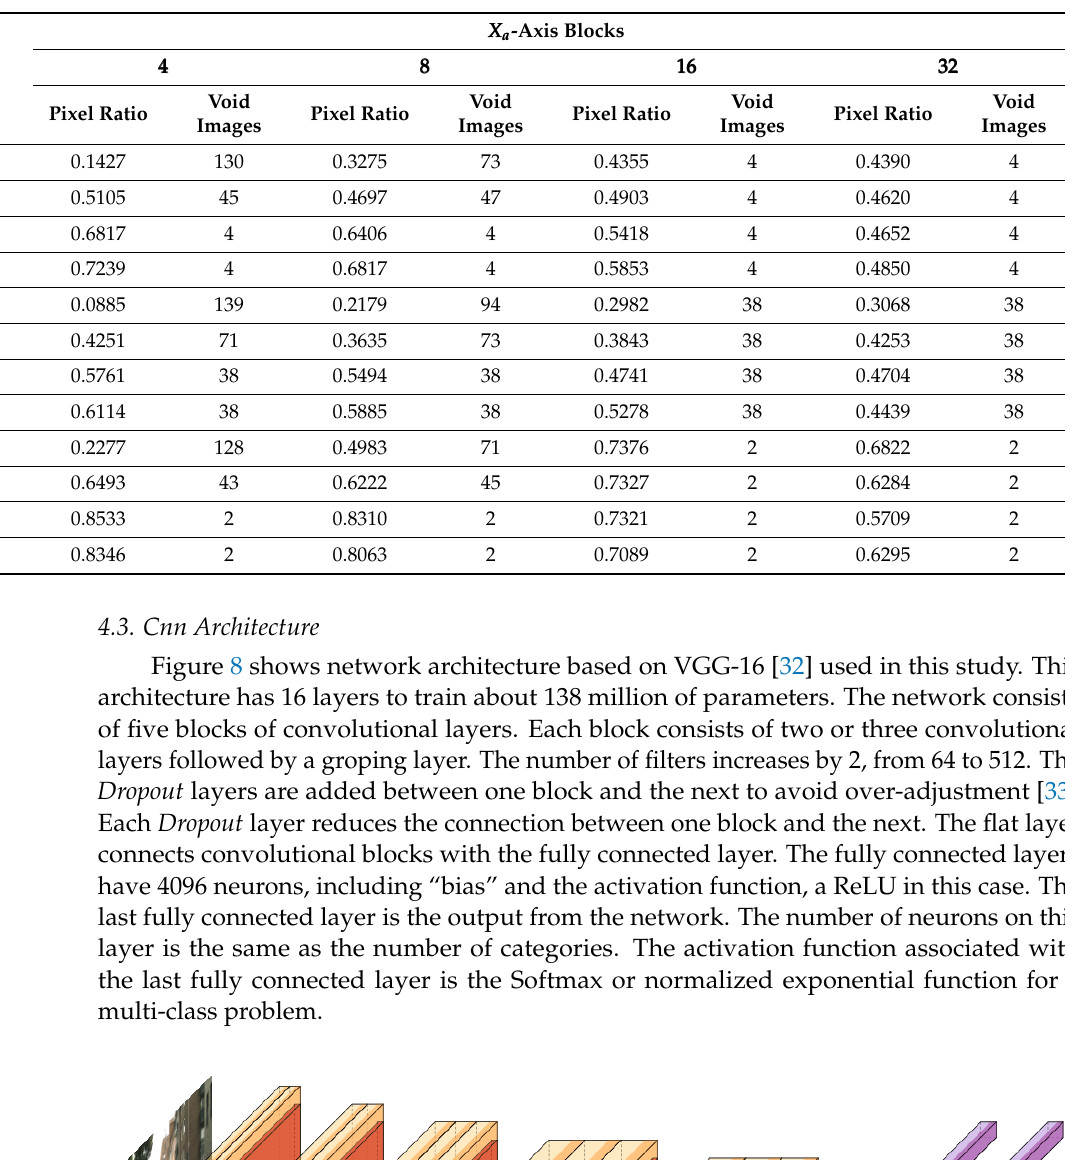
Table 3. Analysis of segmented image categories for CityScape.